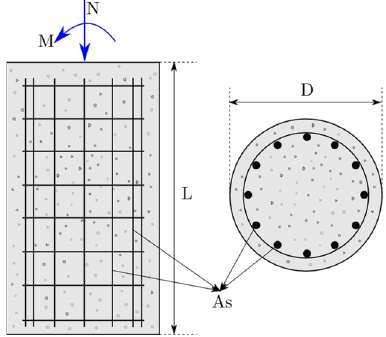
Figure 2. Cross-section and longitudinal section of a circular RC column .